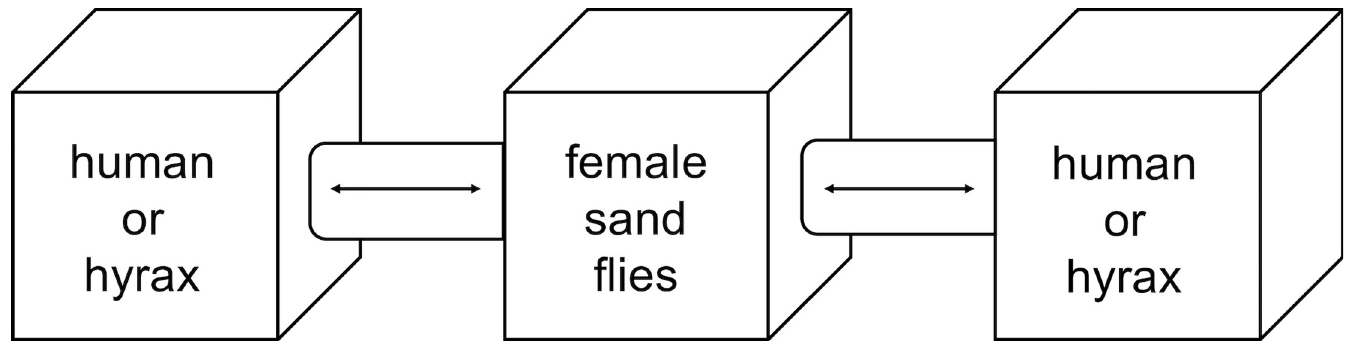
Fig 2. Host choice experiment set-up. Female non-fed sand flies captured from caves were transferred to the middle cage, where they were left for 30 minutes to adapt. Then, the connecting tubes to the lateral cages, where a hyrax and human hand were exposed, were opened to allow sand flies to obtain their preferred blood meal during four hours. The hosts themselves and their places were changed for each iteration of the